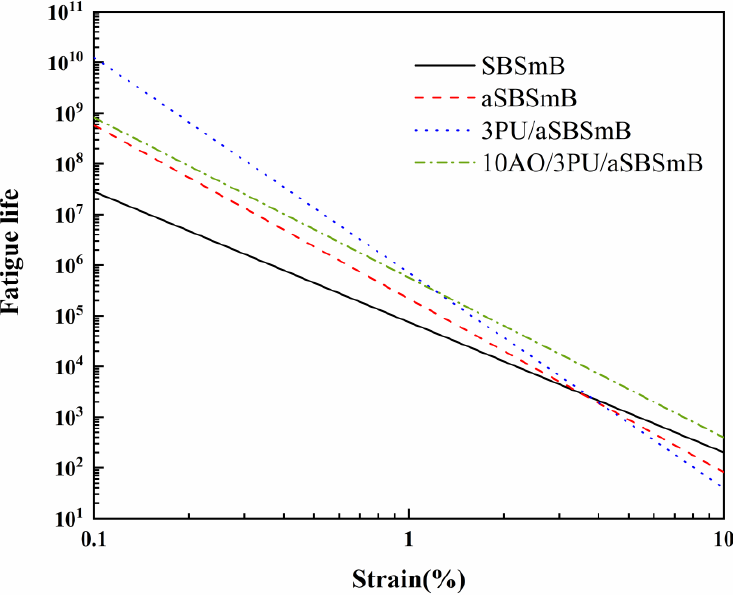
Figure 5. C - D curves of the virgin, aged, and rejuvenated SBSmB.